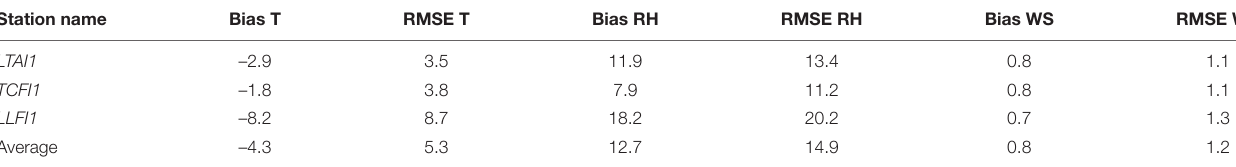
TABLE 4 | WRF-SFIRE meteorological error statistics for weather stations across Idaho during the 2016 Pioneer Fire.